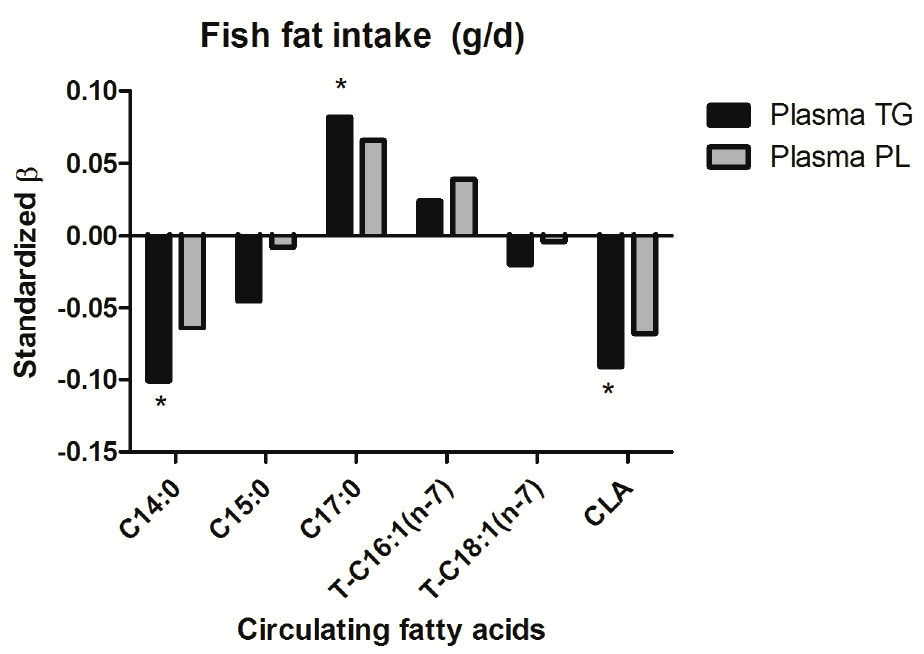
Figure 2. Association between circulating fatty acids from plasma triglycerides and phospholipids and fish fat intake, adjusted for energy intake. *Equal or below significance level P ≤ 0.05.